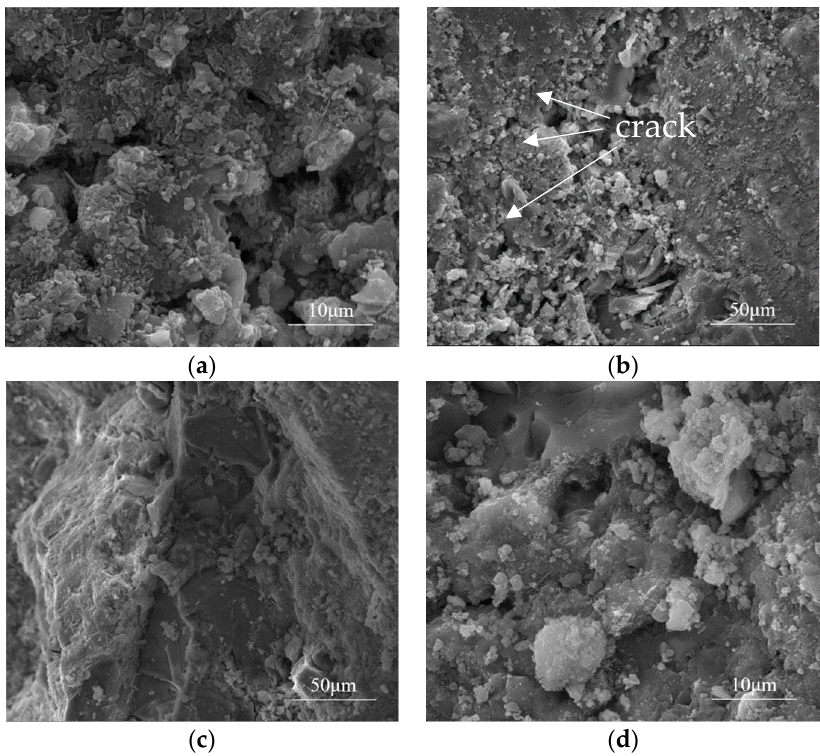
Figure 5. Scanning Electron Microscopy (SEM) diagrams of cement pastes and aggregate interfaces added with different admixtures after 300 sulfate dry–wet cycles; ( a ) OPC; ( b ) QP20; ( c ) SG20; ( d ) FA10.